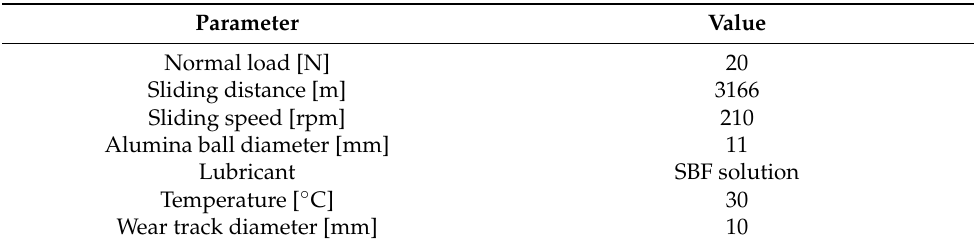
Table 3. Tribological test parameters.